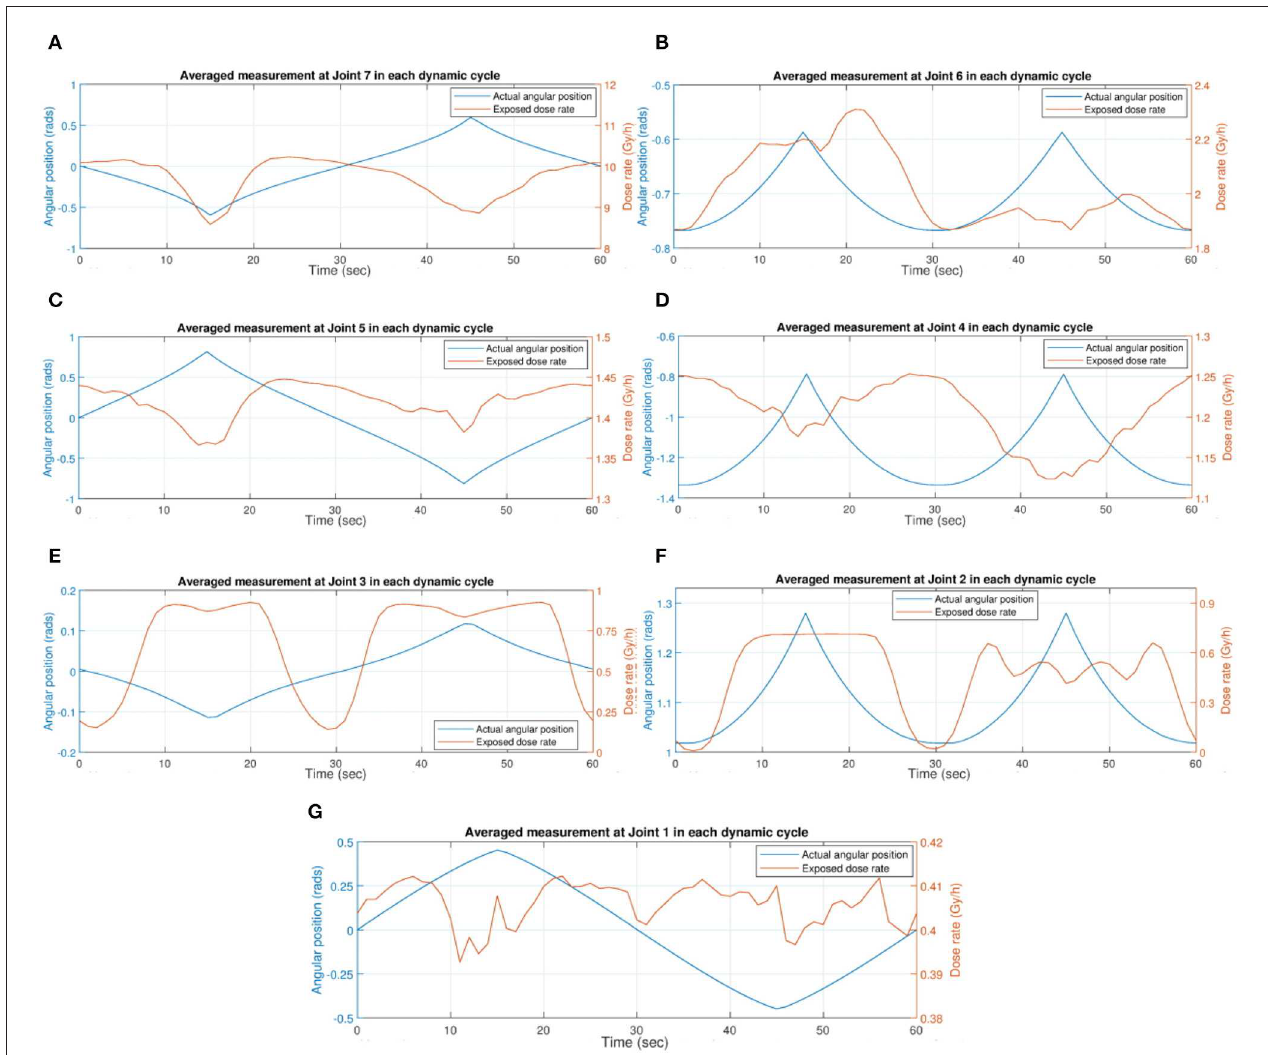
FIGURE 7 | The averaged dose rate and angular position measurements of each dynamic assessment cycle (for 60 s) over 10 cycles. The angular position and exposed dose rates are shown for each joint: (A) at Joint 7; (B) at Joint 6; (C) at Joint 5; (D) at Joint 4; (E) at Joint 3; (F) at Joint 2; and (G) at Joint 1.